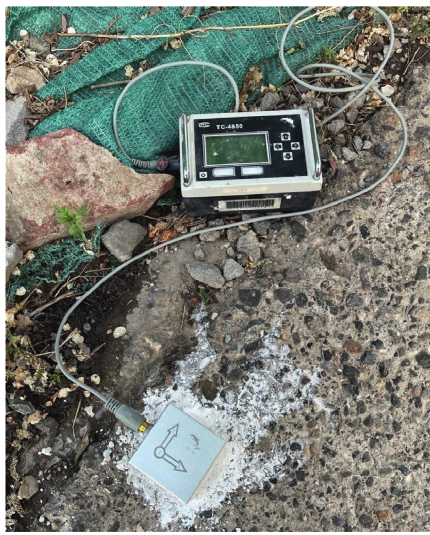
Figure 5: Triaxial vibration velocity transducer